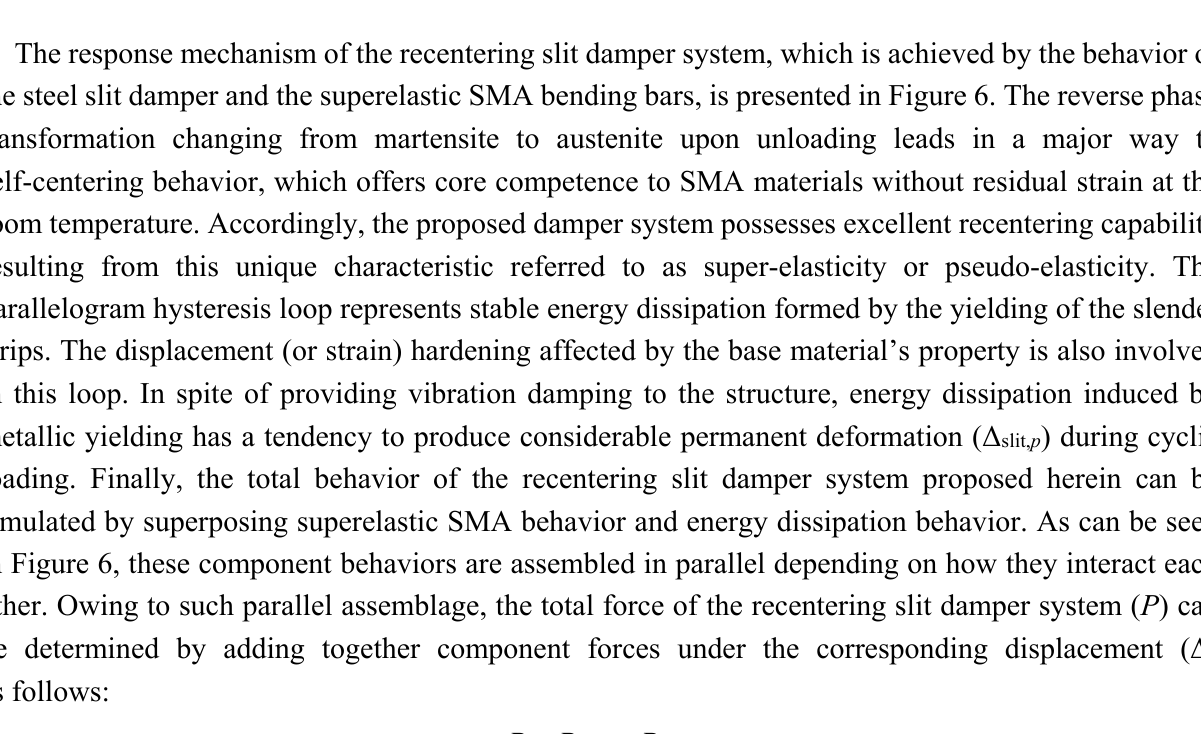
Figure 5. Design of the slit damper system with recentering SMA bars ( a ): Front View; ( b ): Plan View and ( c ): 3D